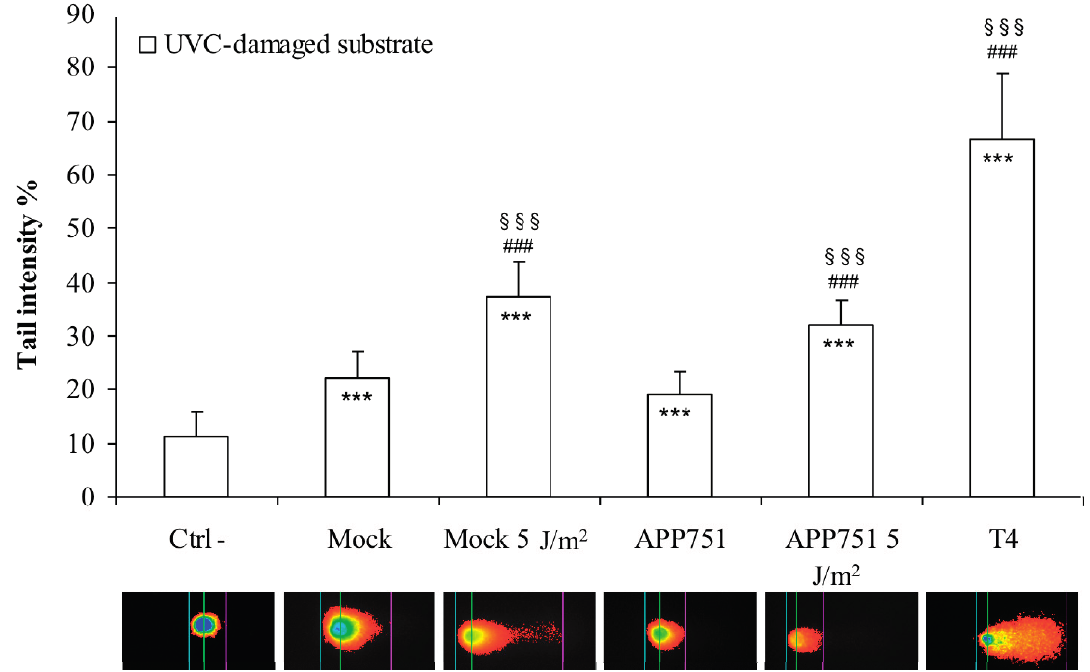
Figure 4. Analysis of photoproducts excision activity after UVC irradiation. Mock and APP751-expressing cells were cultured for 48 h and either left untreated or